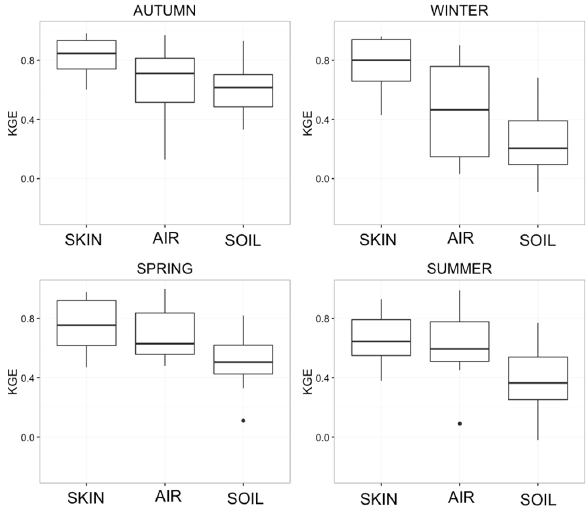
Figure 10. Boxplots of the KGE values obtained by comparing modelled upwelling longwave radiation, computed with different temperatures (soil surface temperature – SKIN, air temperature – AIR, and soil temperature – SOIL), against measured data. Results are grouped by